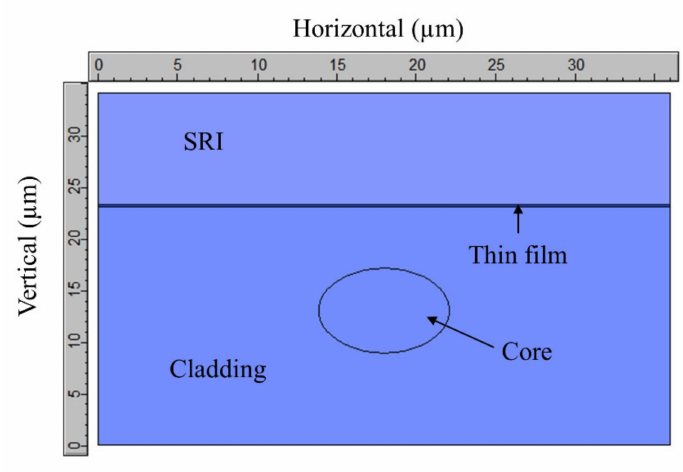
Figure 2. D-shaped fiber as modeled in FIMMWAVE.